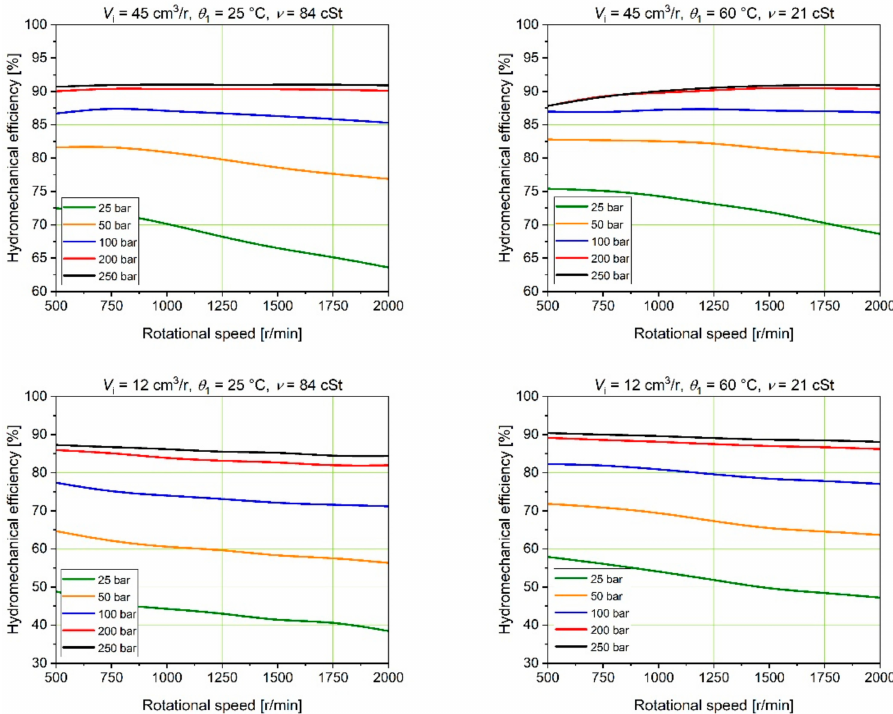
Figure 12. Hydromechanical efficiency of an axial piston pump as a function of rotational speed with five constant pressures. The seven-calculation-point efficiency curves have been smoothed with B-splines. Note the varying efficiency